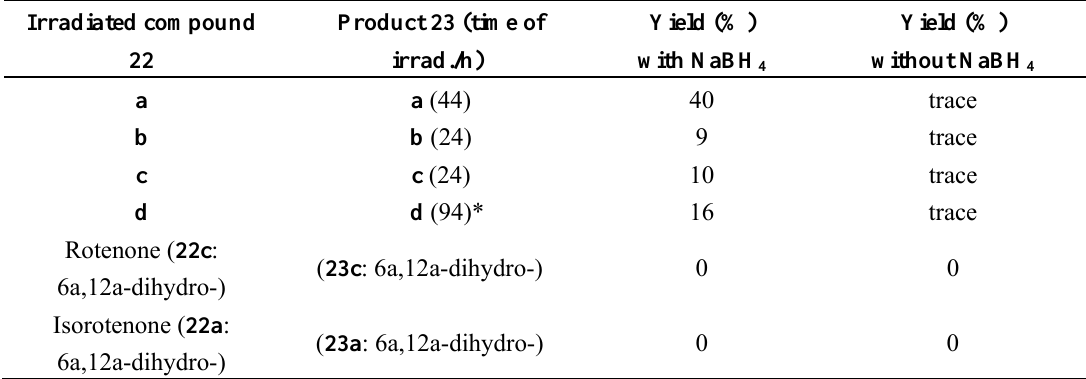
Table 1. Photoinduced oxygenation of